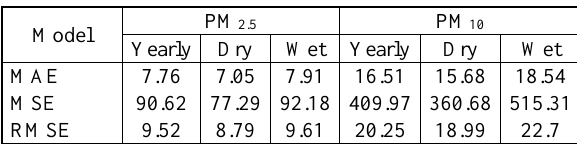
Table 3. Model error measurements of the generated PM models using